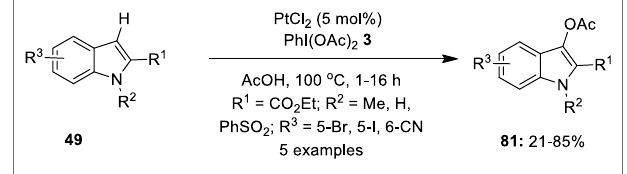
FIGURE 15 | Pt(II)-catalyzed C3-acetoxylation of indoles 49 to afford C3-acetoxylated indoles 81 using PhI(OAc) 2 3